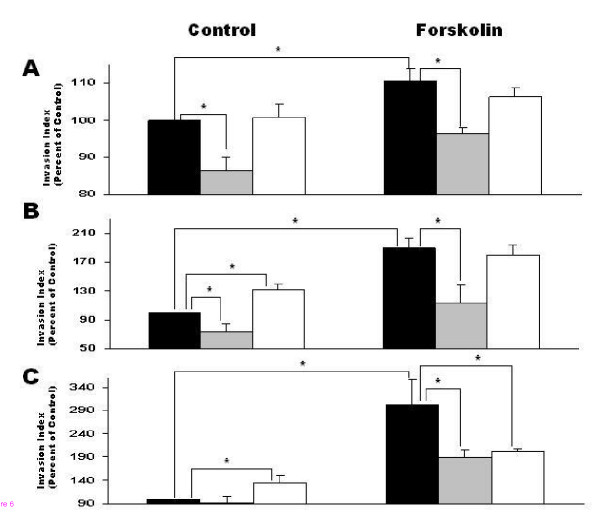
Cell invasion ability of JAR cells, 1st trimester trophoblast cells 6–8 week or 1st trimester trophoblast cells 9–12 week tested with Transwell Invasion Assay. (A) represents JAR cells, (B) 1st trimester trophoblast cells 6–8 week and (C) 1st trimester trophoblast cells 9–12 week. Cells were treated with 10 μM Forskolin and incubated 36 hours on Matrigel coated membrane, with or without MMP-2 or MMP-9 inhibitory antibodies. Cells that invaded the membrane to lower well were counted with XTT. Results represent mean ± SEM from 10 independent experiments. Black bars represent control (cells without treatment or cells treated with Forskolin) with no antibodies. Gray bars represent cells (without treatment or treated with Forskolin) with addition of MMP-2 inhibitory antibody. White bars represent cells (without treatment or treated with Forskolin) with addition of MMP-9 inhibitory antibody. ANOVA for all groups results in p < 0.05, post test confirmed the t test results. *P < 0.05